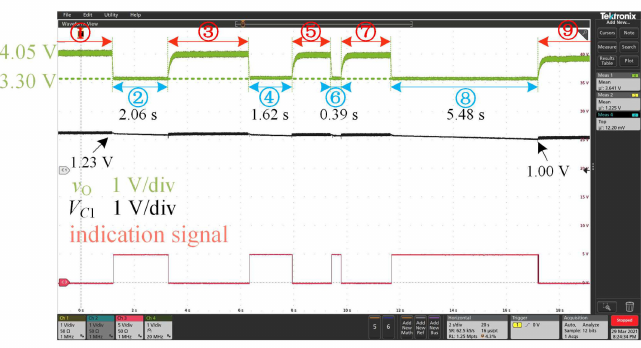
Figure 18. Key waveform of v O , V C 1 and the indication signal with the vibration status changes. Table 3. Performance comparisons with state-of-art power conversions for vibration energy